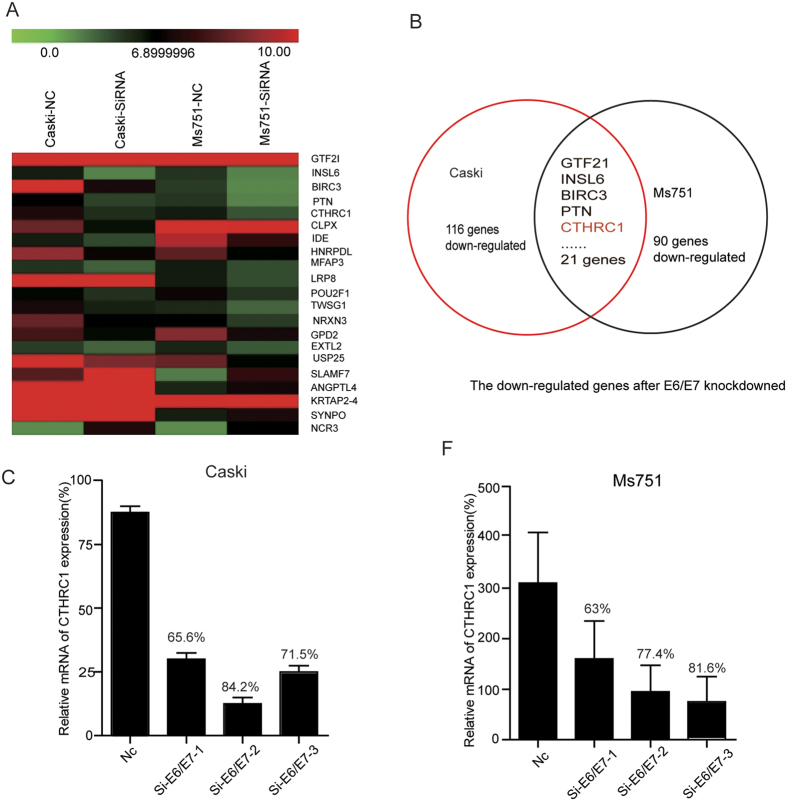
Extracellular matrix expression profile is altered by silencing of E6/E7.(A) 21 genes that encode extracellular secreted proteins were significantly down-regulated in Caski and Ms751 cells with silencing of E6/E7 as compared with control cells (fold change >3 and P < 0.05). (B) Shows a schematic diagram of down-regulated extracellular secreted proteins. (C) The expression of CTHRC1 in Caski cells with silencing of E6/E7, detected by RT-PCR and normalized with 18S expression. (D) The expression of CTHRC1 in Ms751cells with silencing of E6/E7, detected by RT-PCR and normalized with 18S expression.